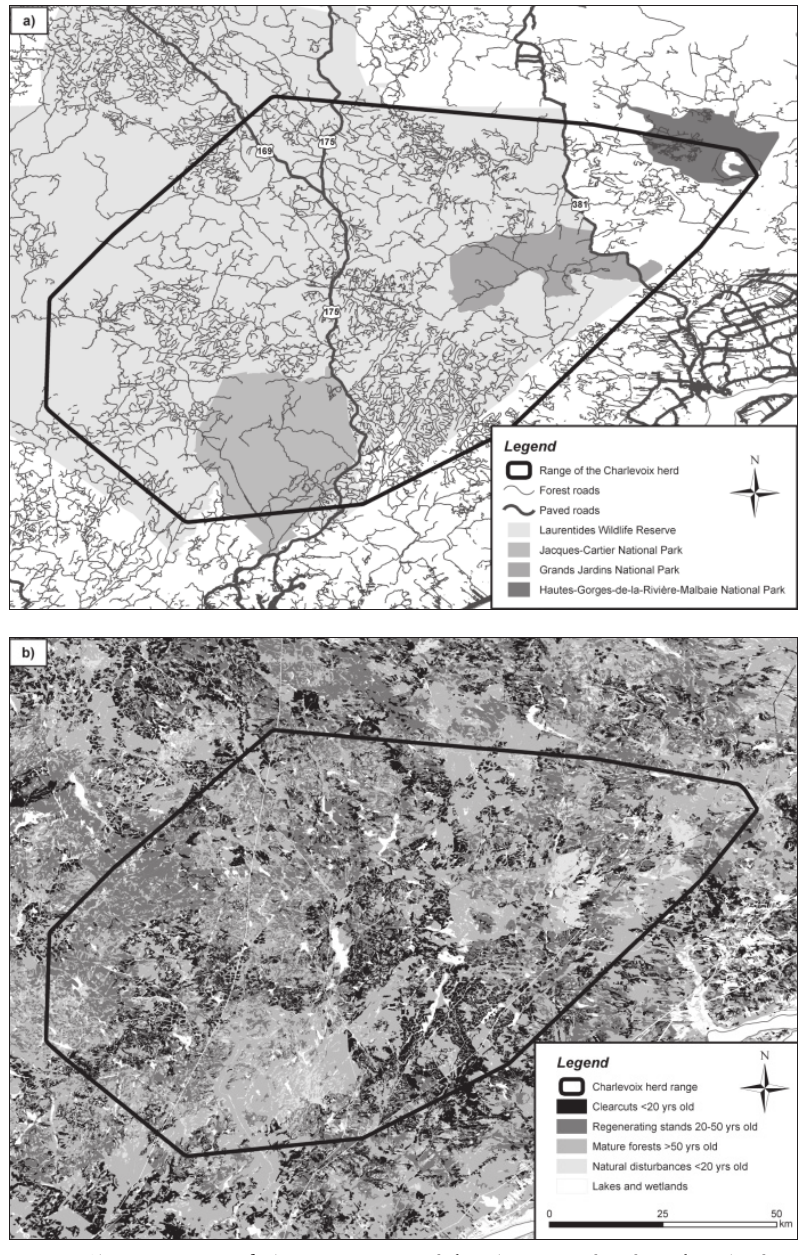
Fig. 3. Characterisation of the range occupied by the reintroduced caribou herd in Charlevoix between 2004 and 2010 (MCP 100%). Habitat characteristics were determined using ecoforest maps updated in 2009 by the Ministère des Ressources naturelles et de la Faune du Québec (MRNF). (a) Map showing road density (both paved and forest roads) and boundaries of the Laurentides Wildlife Reserve, Jacques-Cartier National Park, Grands-Jardins National Park and Hautes-Gorges- de-la-Rivière-Malbaie National Park. (b) Map showing the abundance and configu- ration of clearcuts, regenerating stands, mature forest and naturally disturbed forest